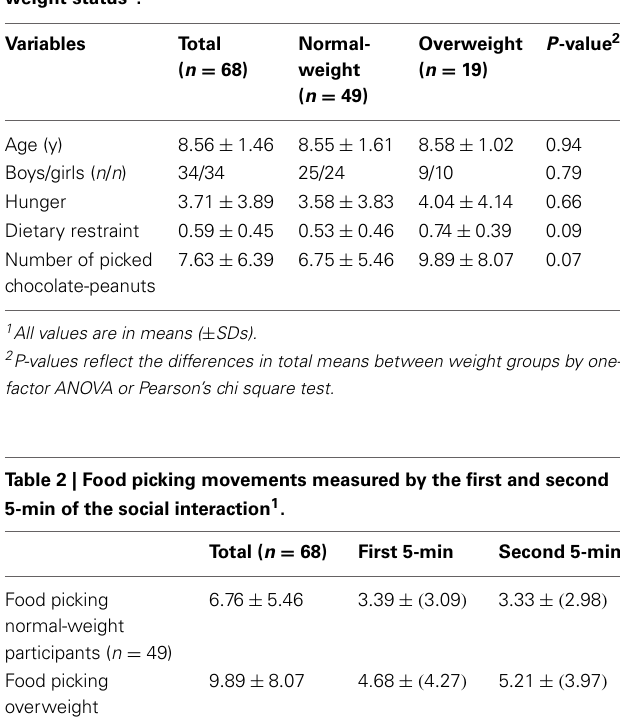
Table 1 | Means ( SD ) for variables age, sex, hunger, dietary restraint, and total number of picked chocolate-coated peanuts measured by weight status 1 .